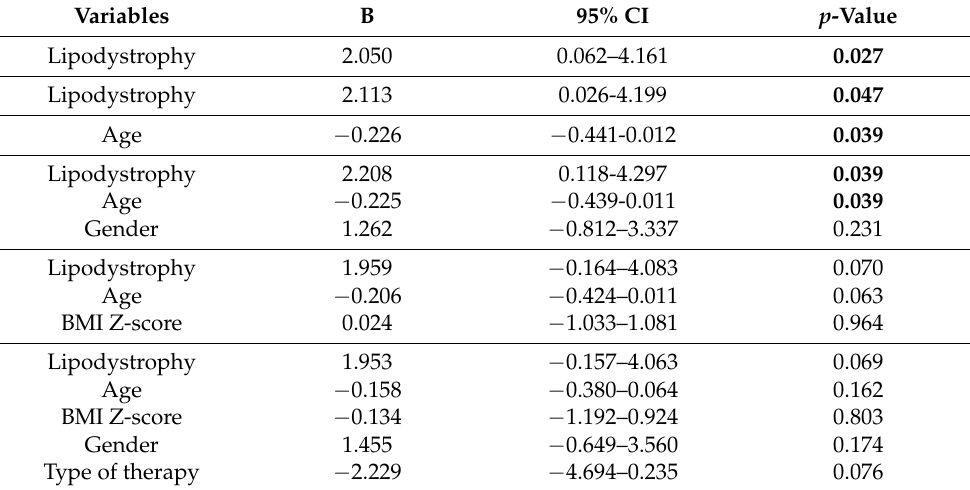
Table 3. Multiple linear regression models for the coefficient of